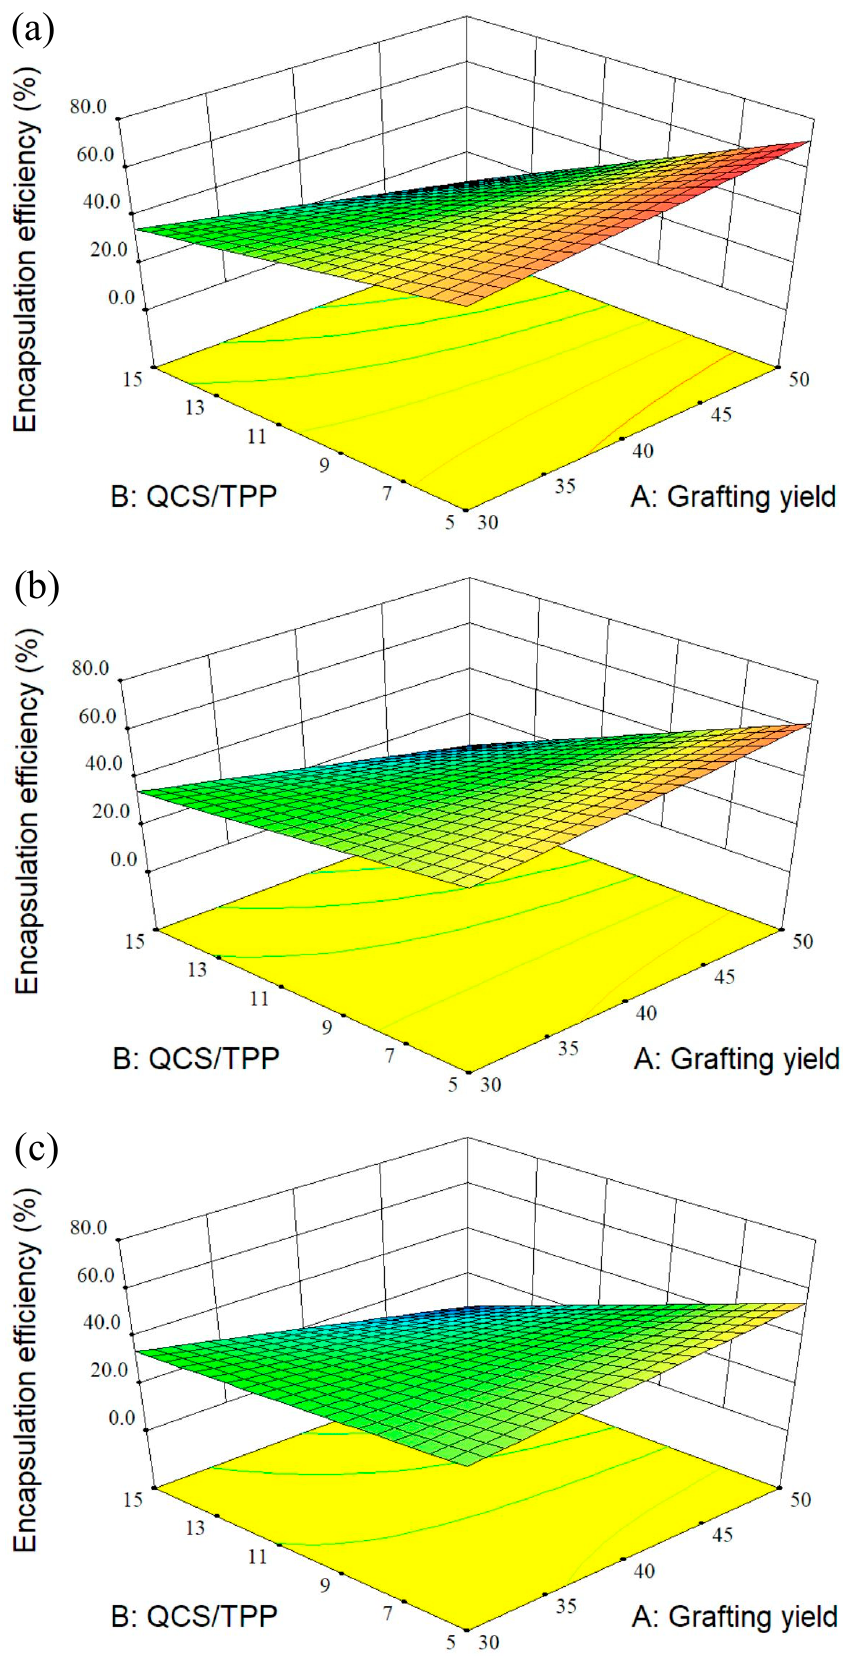
Figure 7. 3D response surface plots showing the effects of grafting yield and weight ratio of QCS/TPP at different weight ratios of QCS/genipin of ( a ) 20/1, ( b ) 40/1, and ( c ) 60/1 on encapsulation efficiency.